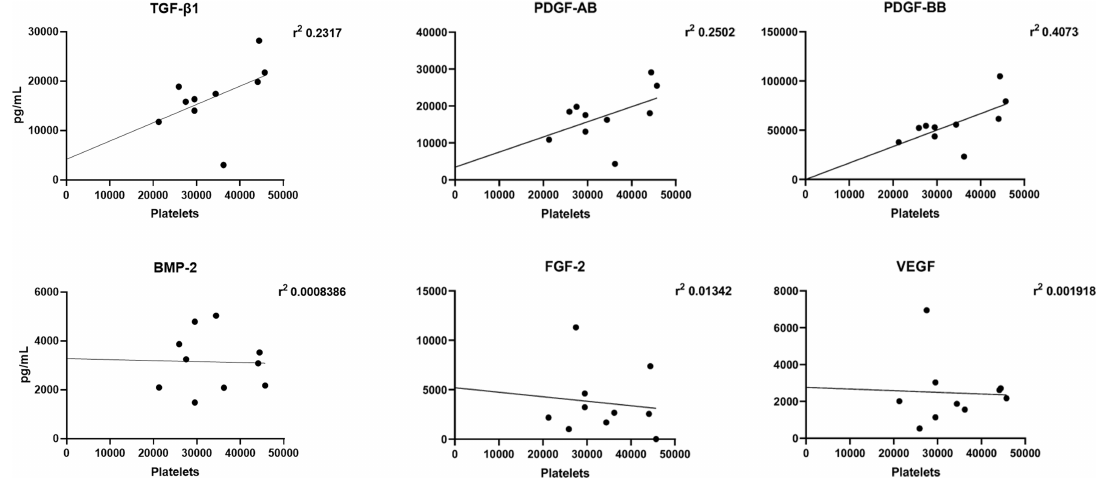
Figure 4. Correlation between released growth factors and accumulation of platelets. Statistical analyses were performed to correlate the release of growth factors and the platelet accumulation.